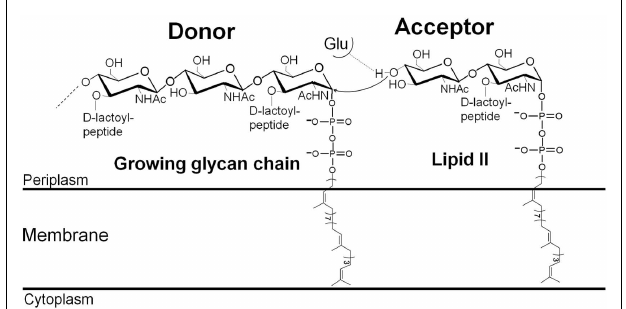
FIGURE 1 | Mechanism of glycan chain polymerization by a glycosyltransferase.